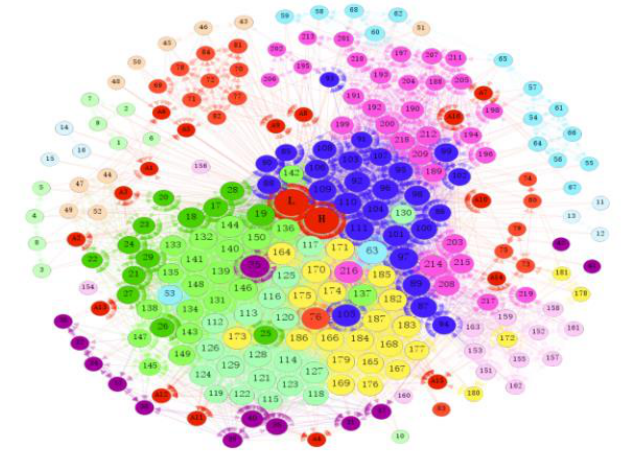
Fig. 4. Hospital referral network II of